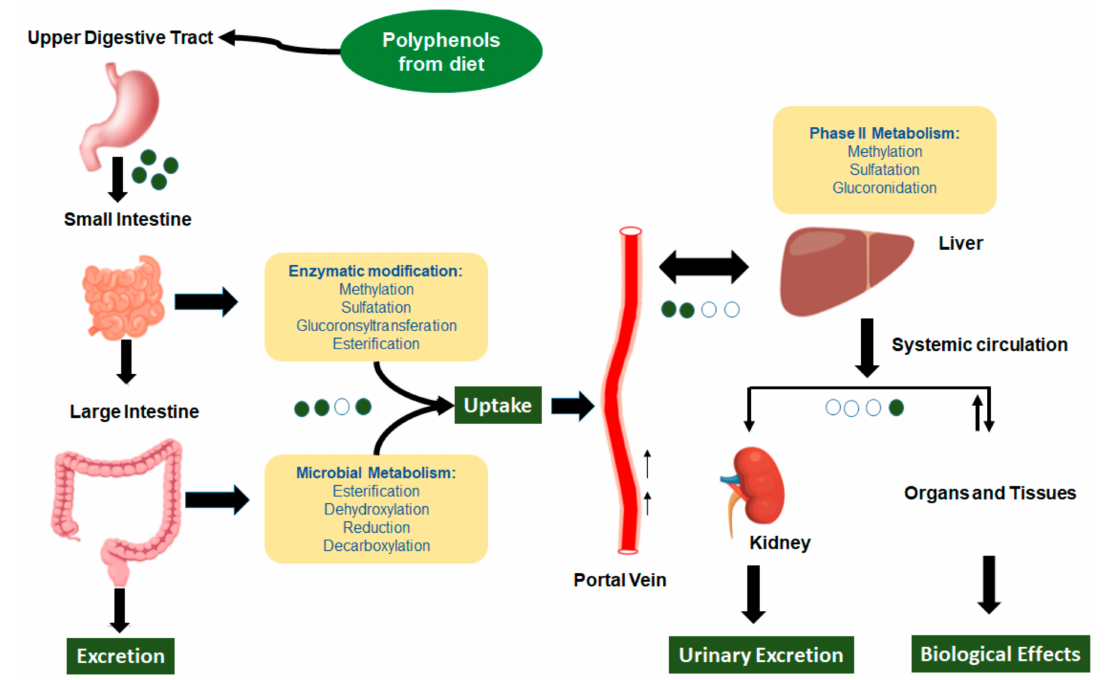
Figure 2. Schematic representation of the absorption and metabolism of dietary polyphenols. Green dots represent aglycon polyphenols, and white dots represent their